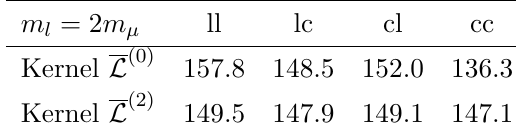
Figure 10 . Continuum extrapolation of the lepton-loop contribution using the kernel L (0) (left panel) and L (2) (right panel) using Method 1. We use m l = 2 m µ . The colors correspond to different discretizations of the correlation function. The horizontal dashed line represents the exact result.